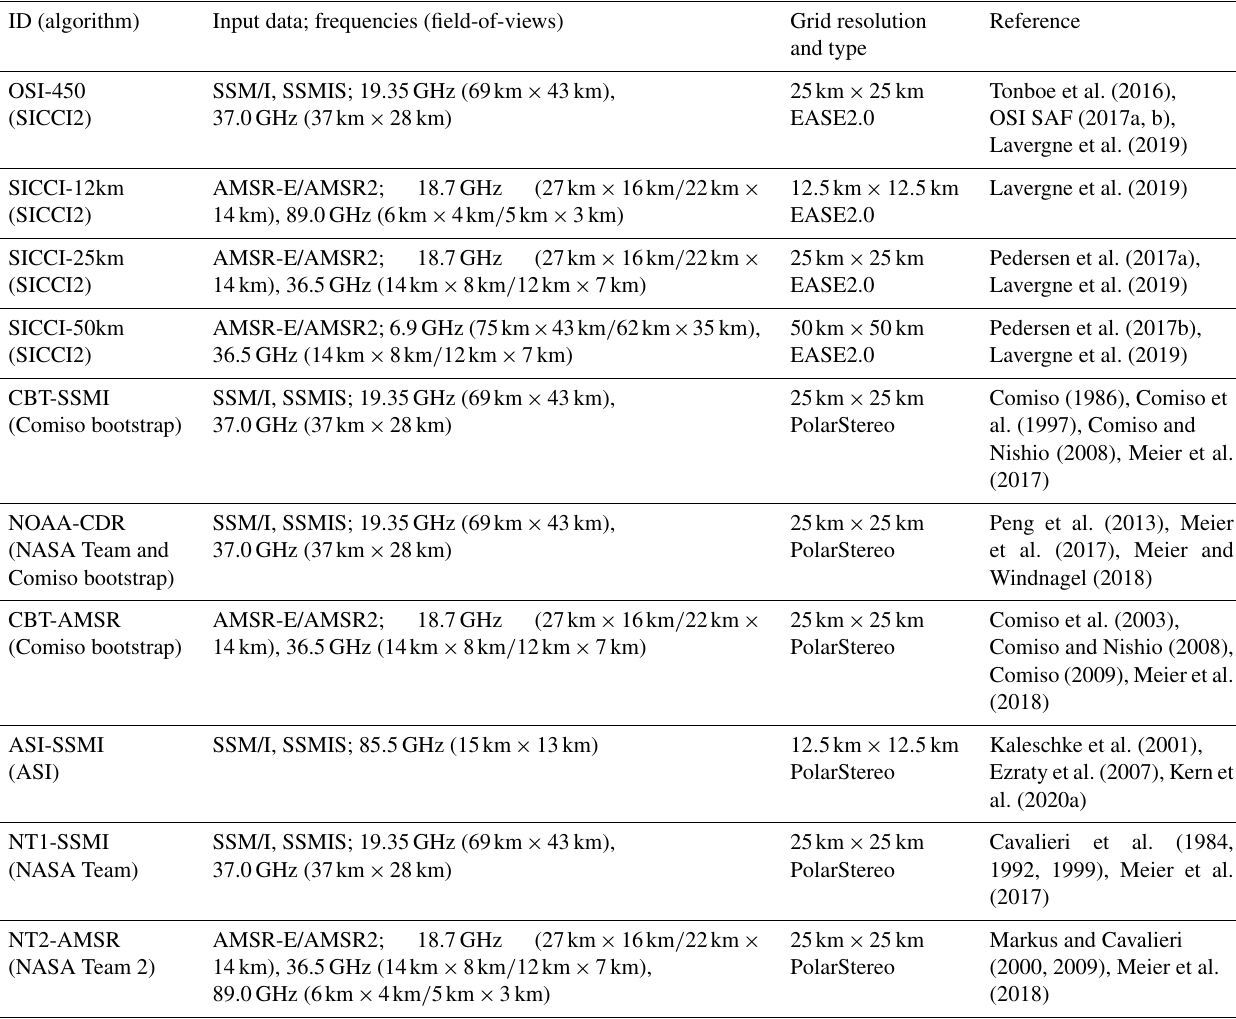
Table 1. Overview of the investigated PMW SIC products. Column “ID (algorithm)” holds the identifier we use henceforth to refer to the data product and which algorithm it uses. For those algorithms for which an AMSR sensor forms part of the name, we refer to AMSR-E or AMSR2, depending on the respective data used; we write AMSR if we refer to products from both satellites. Column “Input data” refers to the input satellite data for the data set, together with the frequencies and respective field-of-view